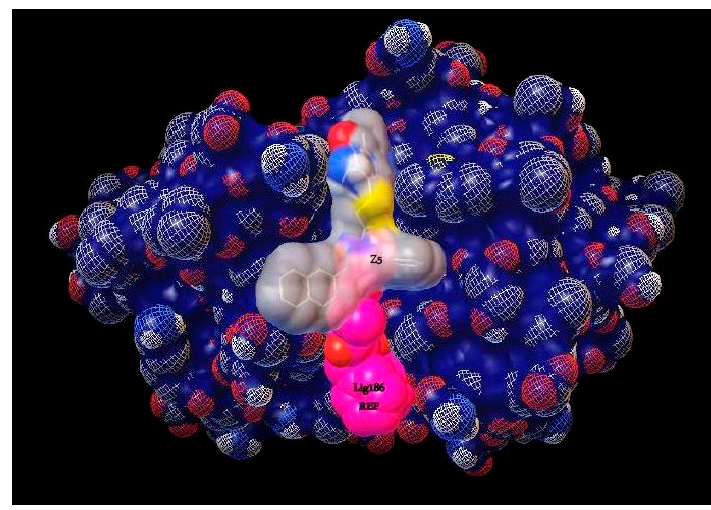
Figure 5. Analysis of the interaction site between ligand 186 and compound Z5 on Cz.